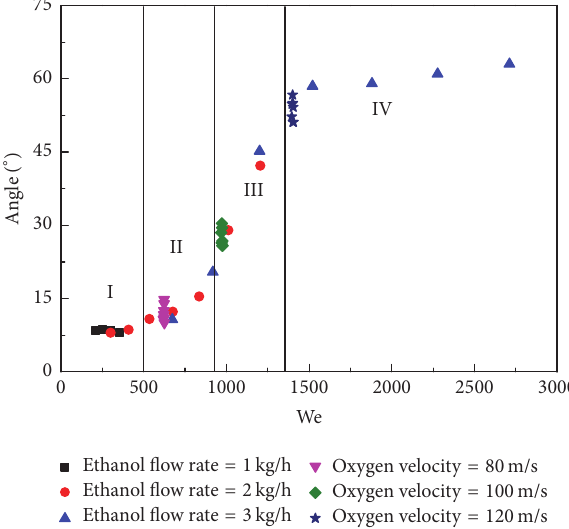
Figure 4: Flame spray angle as function of